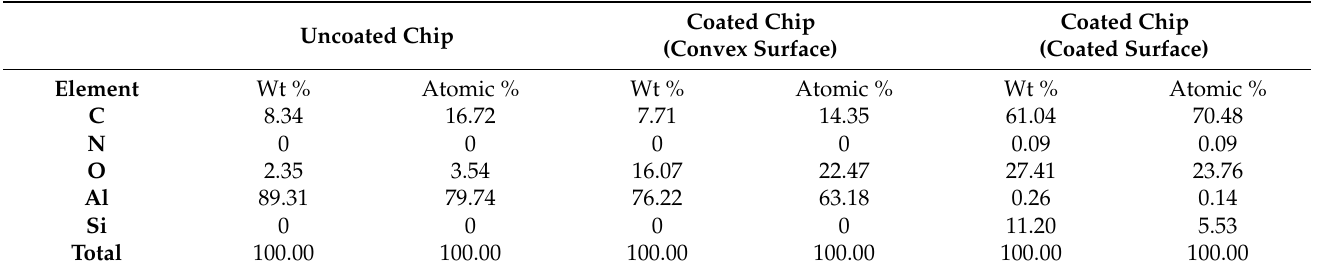
Figure 2. ( a ) SEM image of the tested area for EDS mapping. ( b ) EDS mapping result for Al element on the tested site; two areas framed in different colors will be plotted in the map sum spectrums. ( c ) Map sum spectrum for the convex surface of the chip, red frame in Figure 2b. ( d ) Map sum spectrums for the coated surface of the chip, green frame in Figure 2b. Table 1. The element content of the uncoated and coated chip